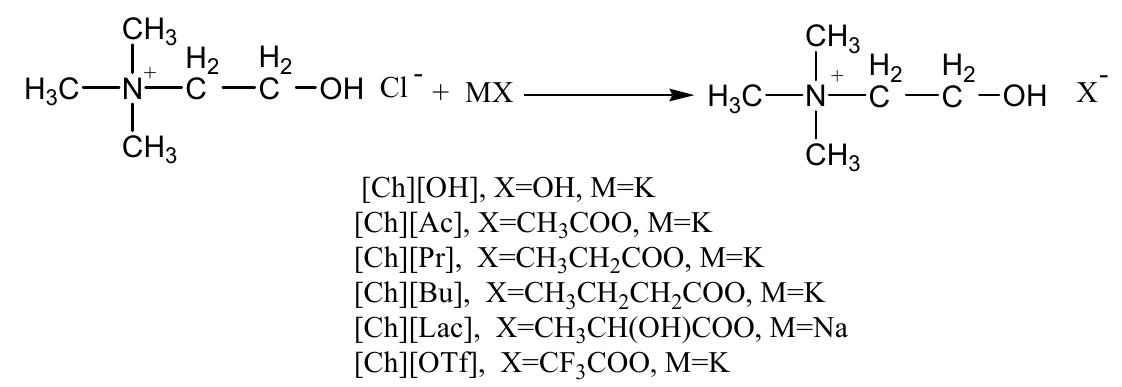
Scheme 1. Preparation of choline hydroxide based ionic liquids.